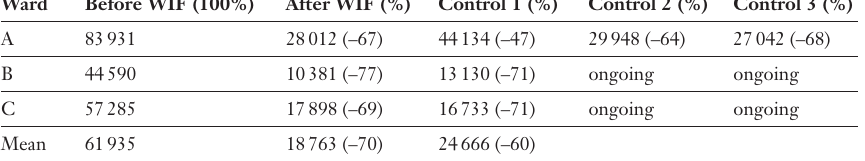
Bound capital ( r ) be- fore and after intro- ducing the ward-indi- vidualised formulary